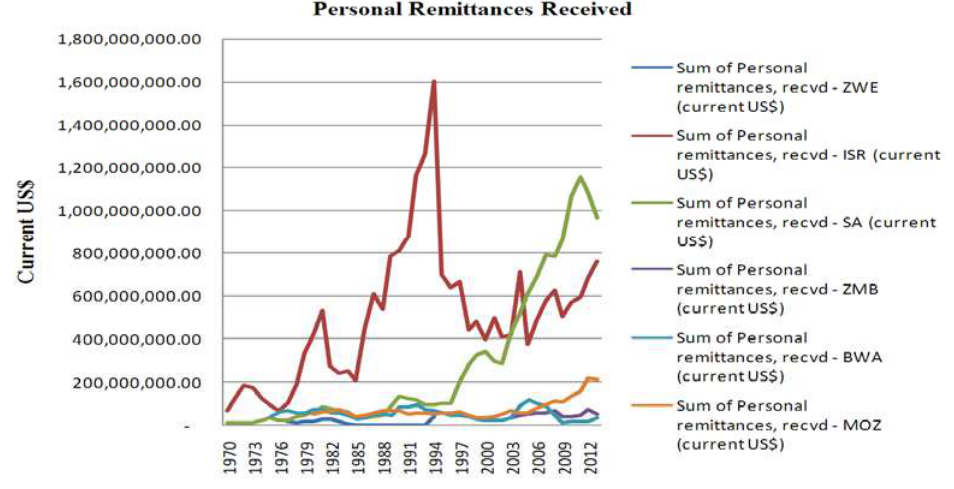
Fig. 6. Personal remittances